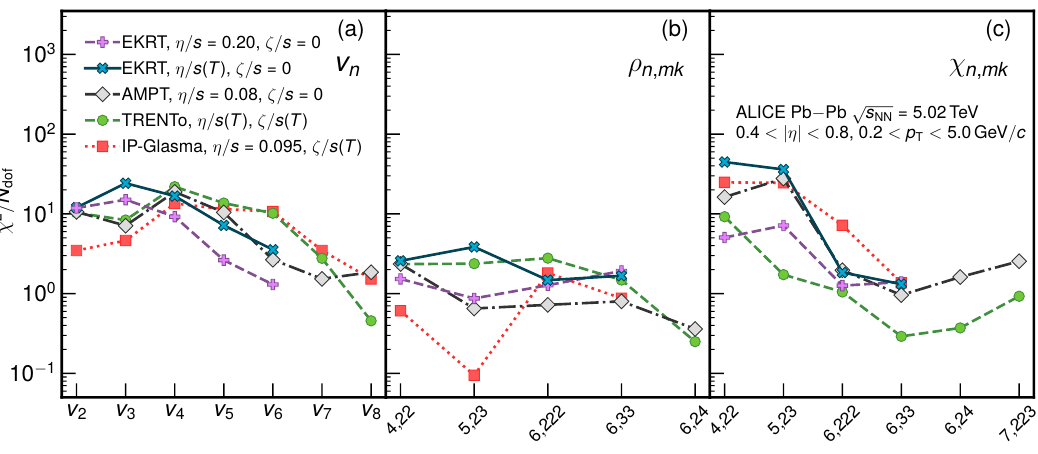
Figure 7 . Overview of various model comparisons with data, quanti(cid:12)ed by (cid:31) 2 =N dof . Lower (cid:31) 2 =N dof represents a better overall description for a given